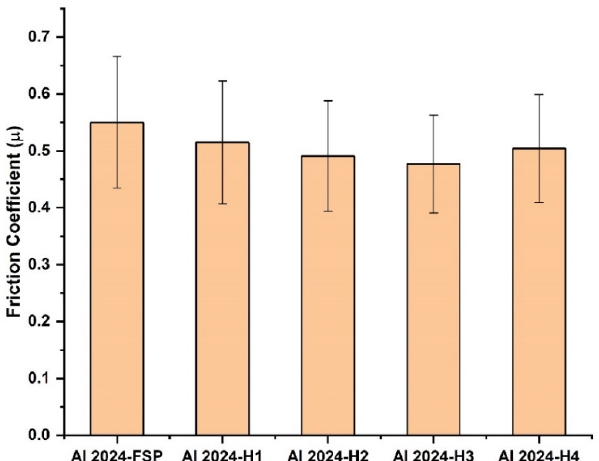
Figure 11. Mean value of the friction coefficient.